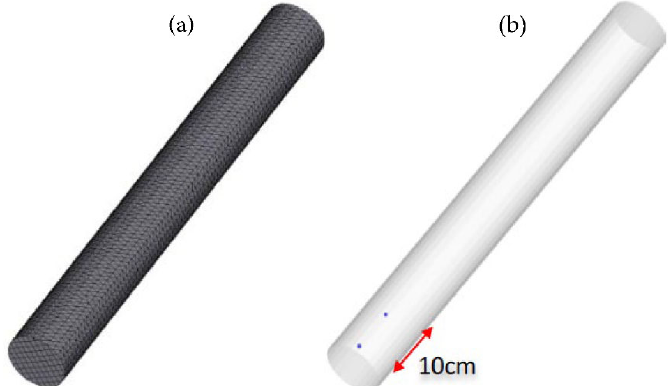
Figure 6. ( a ) Cylindrical mesh used in the simulations. ( b ) Transient data points for monitoring the total pressure. total